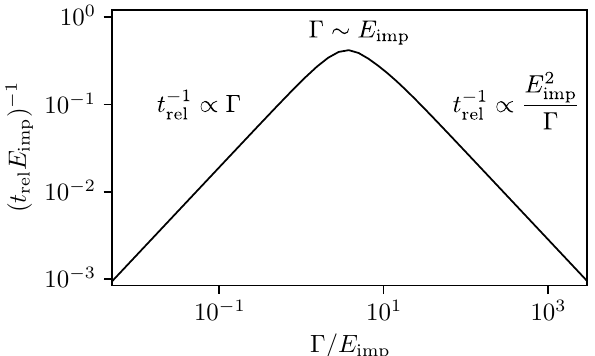
Figure 5: Rate of the relaxation to the Laughlin state, 1 / t , as a function of the refill- rel ing rate Γ in a small disordered system with no loss, κ = 0. Due to the latter condition = 5 the dissipative dynamics of quasiholes is absent. The plot is produced for N 1 / 2 = 100 assuming that E (cid:28) ħ h ω and N (where E is the disorder-induced c imp imp imp broadening of the LLL and ω is the cyclotron frequency). At Γ (cid:174) E the relaxation c imp rate is proportional to the refilling rate. In this regime, the quasiholes quickly move due to the disorder and can efficiently recombine; the relaxation rate behaves as if ∝ Γ . This trend breaks at Γ ∼ E the fractionalization was absent, t − 1 . At higher imp rel refilling rates, Γ (cid:166) E , the dynamics becomes Zeno-blocked and the relaxation rate imp = 0 the system would decreases with increasing refilling rate. Note that if κ = E imp = be stuck in dark states indefinitely never reaching the Laughlin state, 1 / t rel